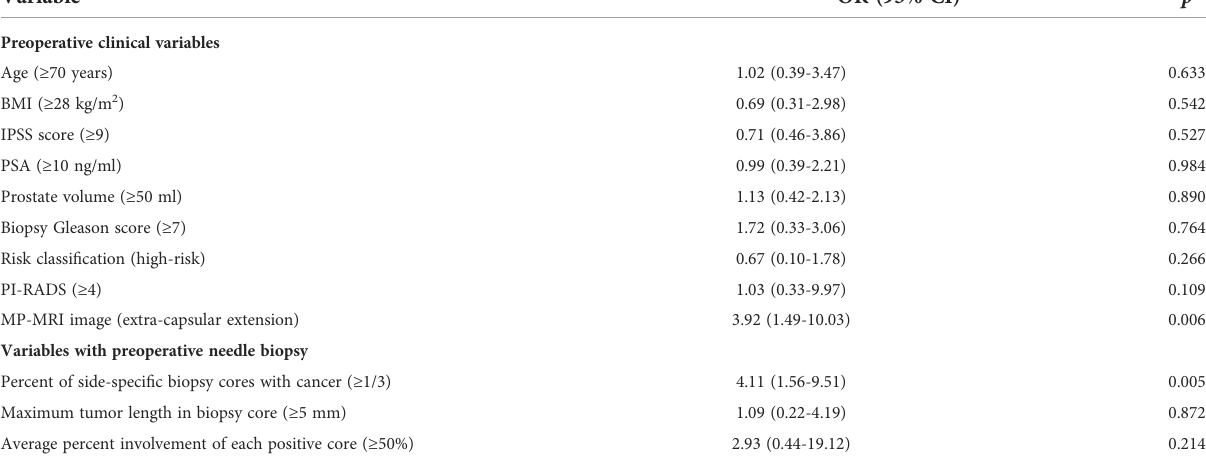
TABLE 3 Multivariate analysis of preoperative variances and the N-T distance. Variable